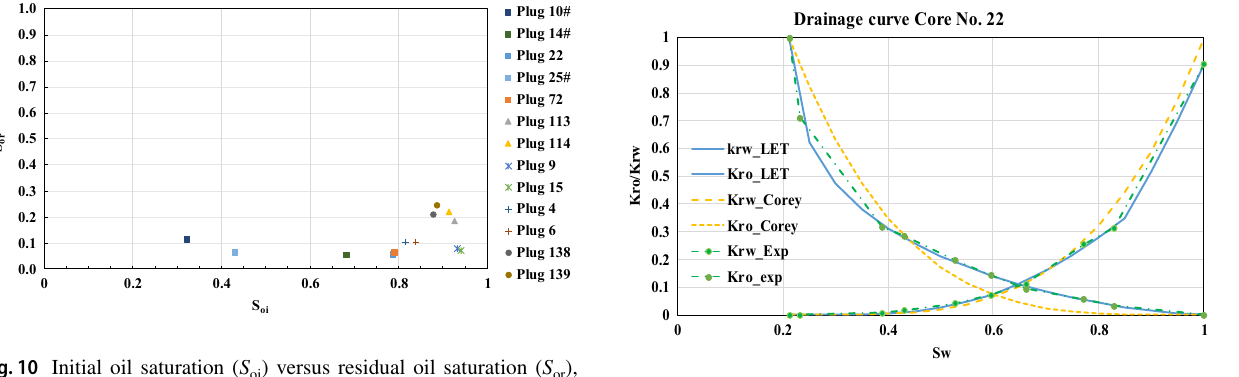
oi ) versus residual oil saturation (